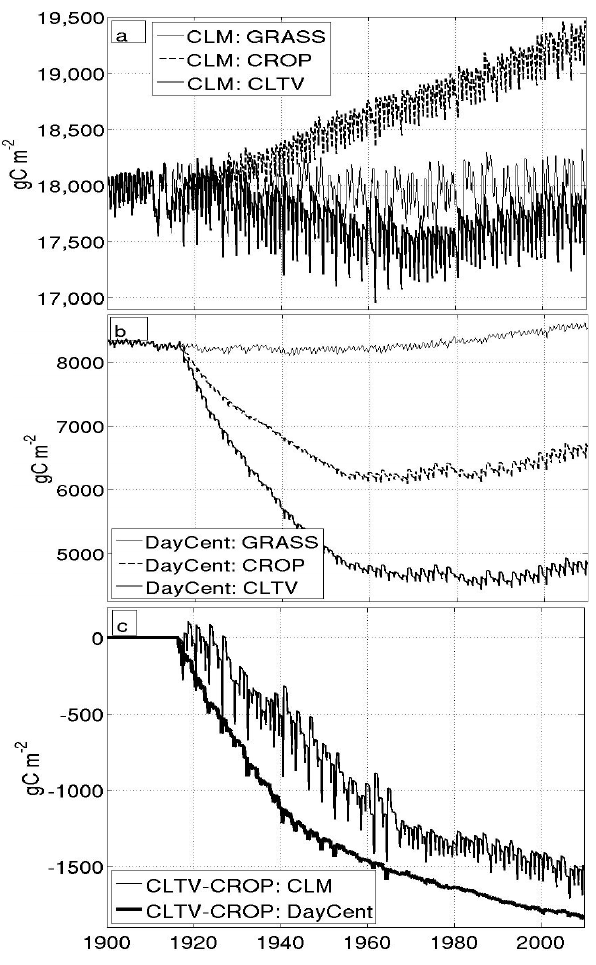
Fig. 1. Soil carbon (gm − 2 ) from the GRASS, CROP, and CLTV simulations in Dunn County, North Dakota Simulations defined in Sect. 2. Showing years 1900–2010 (a) from CLM’s top ∼ 29cm of soil depth, (b) from DayCent’s ∼ 20-cm soil, and (c) the data from (a) and (b) as the difference between CLTV and CROP.